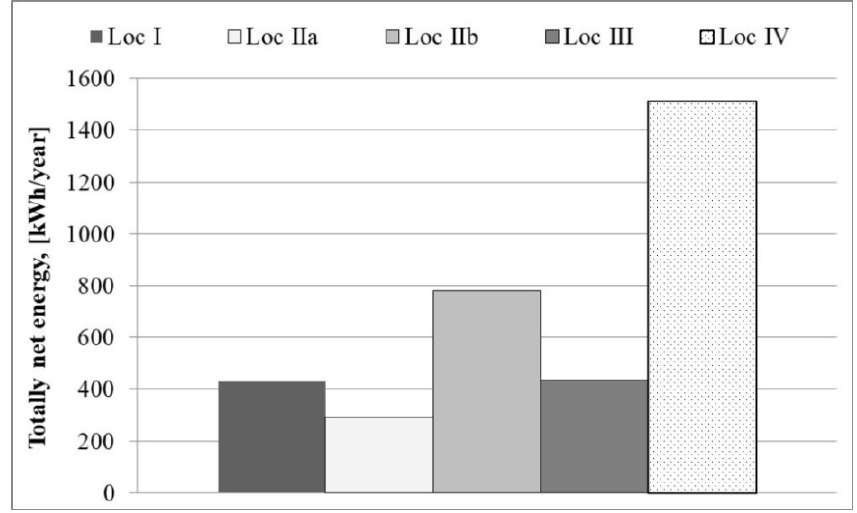
Figure 13. Amount of energy supplied to the power grid by the wind turbine WT1.